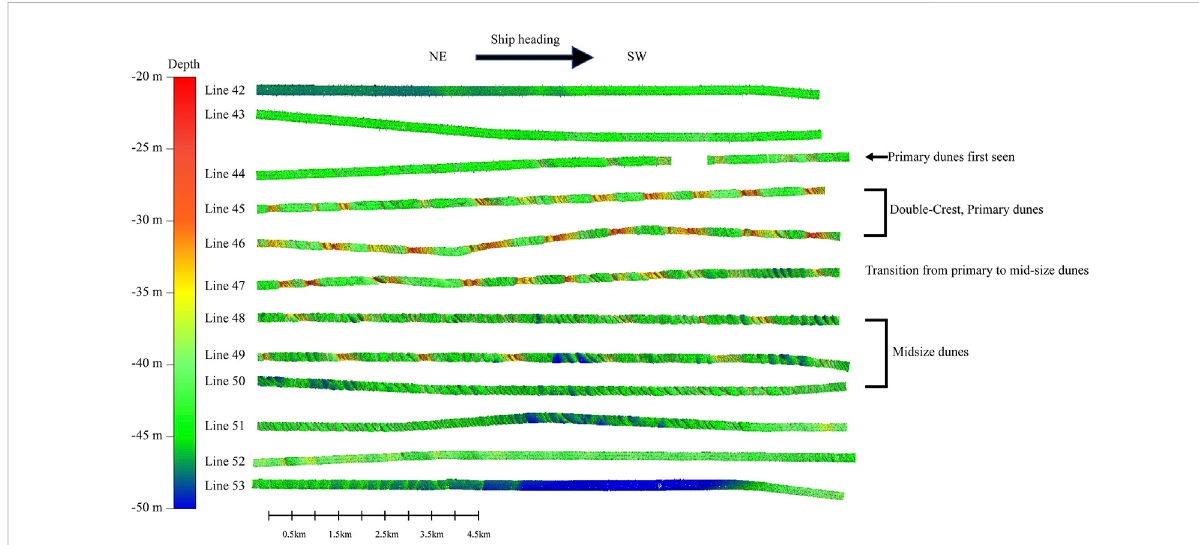
FIGURE 2 The overall morphological characteristics of dunes from the multibeam survey lines. The smaller secondary sandwaves are too small to be clearly identi fi